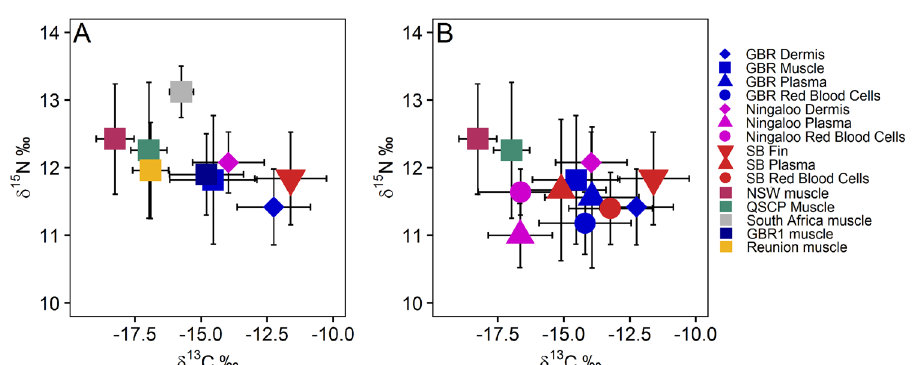
Figure 2. Mean and standard deviation stable isotopic composition of each tissue for each of the locations sampled (SB = Shark Bay, GBR = Great Barrier Reef, NSW = New South Wales, QSCP = Queensland Shark Control Program) for ( A ) slow tissues (muscle, dermis, fin) and ( B ) multiple tissues (muscle, dermis, fin, red blood cells, plasma), for sites where multiple tissues were collected. Data from GBR1, Reunion Island and South Africa obtained from published studies 39, 40, 68